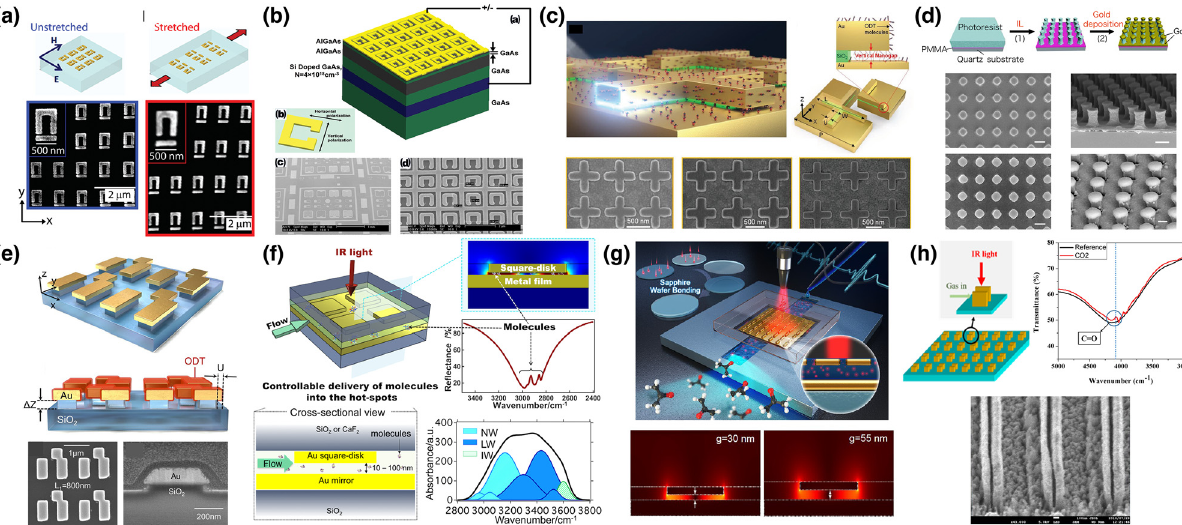
Figure 5: Metamaterial-based SEIRA structures with advanced functionalities. (a) The schematics and SEM images of coupled Au SRR-bar structure fabricated on PDMS substrate before and after substrate stretching. (b) Electricallytunablemid-infraredmetamaterialstructuremadeofAlGaAs/GaAwithitsSEMimages.(c)Theschematicsoftheinfraredmetamaterial absorberwithverticalnanogapanditsunitstructure.TopviewofSEMimagesofdifferentverticalnanogapstructuresisalsoshown.(d)Fabrication procedure and SEM images of fabricated gold mushroom array structure. (e) The schematics of the Fano metamaterial structure on the SiO 2 nanopedestal with top and cross-sectional SEM images. (f) The schematic of metamaterial-nano fl uidics hybrid structure for ultrasensitive platform for SEIRA. Retrieved vibrational modes of water measured by the device are also shown. (g) Self-driven Al 2 O 3 -based 3D plasmonic and nano fl uidichybriddeviceanditssimulatedelectrical fi elddistributions.(h)VerticalMIMmetamaterialstructureforgassensingapplicationandits SEM image. SEIRA spectrumof carbondioxide isalsoshown.[(a) Reproducedfromreference[74].Copyright ©2010,AmericanChemical Society; (b) reproduced from reference [76]. Rights managed by AIP Publishing. (c) Reproduced from reference [79]. © 2021 The authors. Small